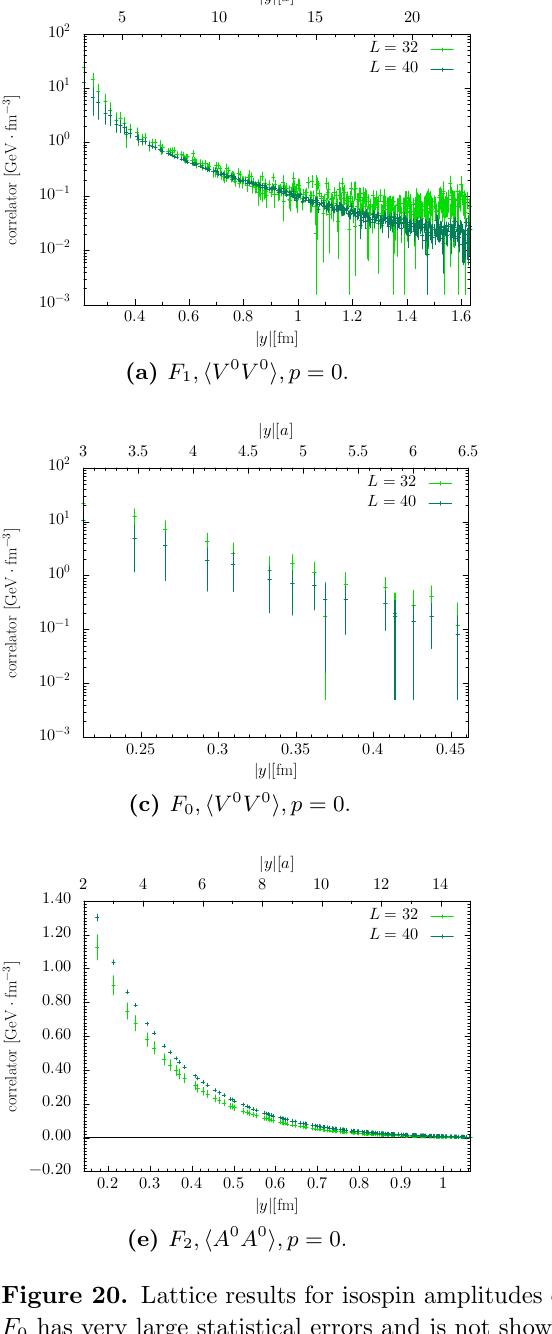
V 0 V 0 and A 0 A 0 . The channel h i h i